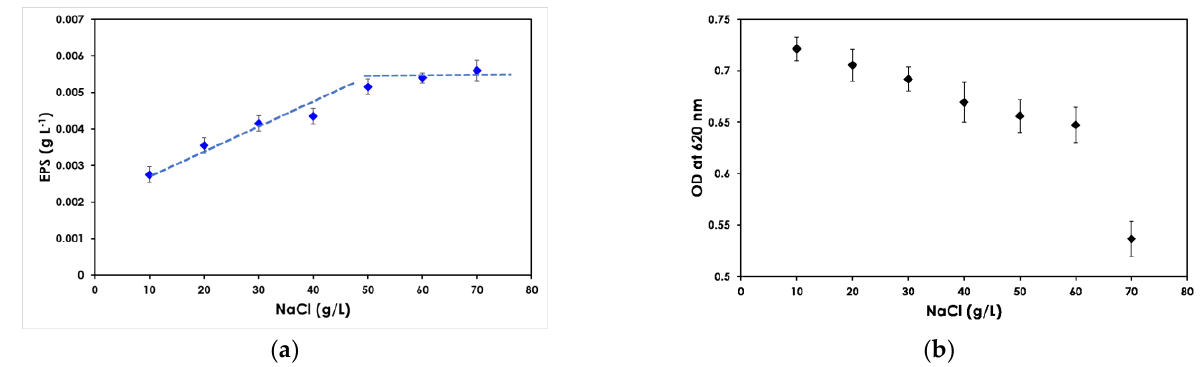
Figure 1. Effect of salinity on EPS production ( a ) and cell growth (measured as OD 620 ) ( b ) during cultivation of the BU-4 strain in glucose-based medium.